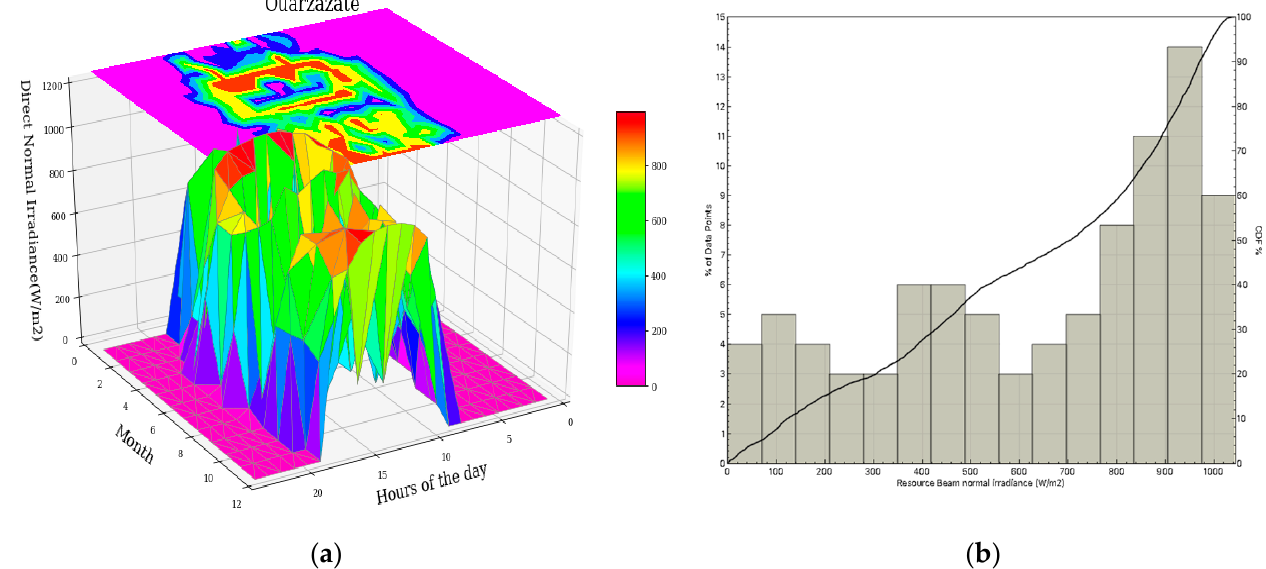
Figure 3. ( a ) Distribution of the hourly DNI values. ( b ) Probability and cumulative density function of the DNI of Ouarzazate, Morocco .